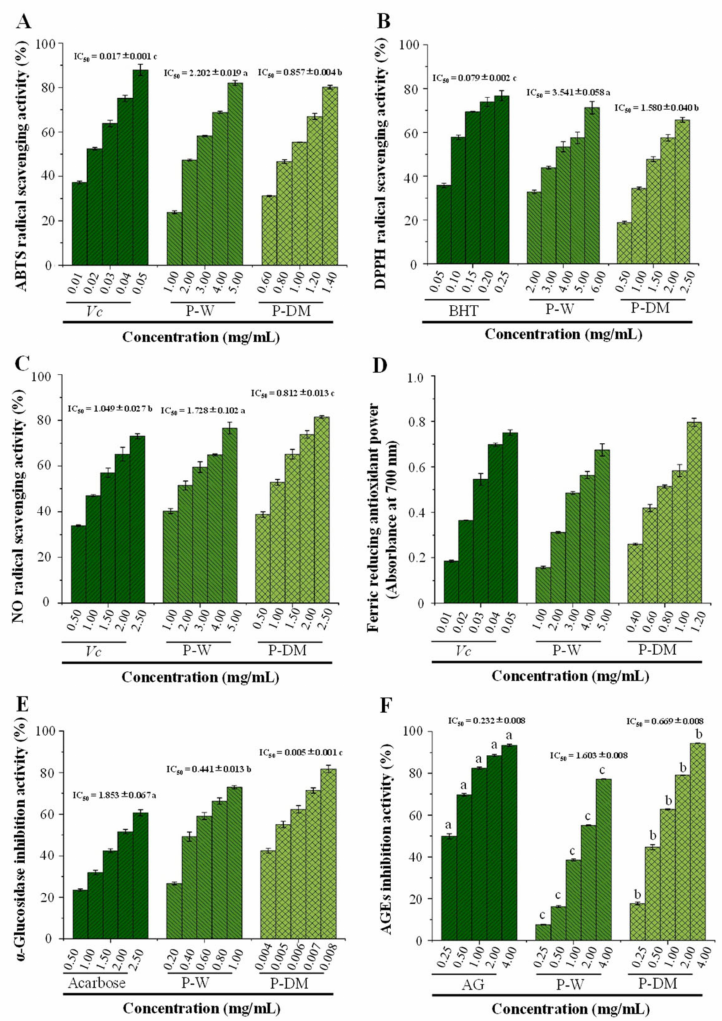
Figure 6. ABTS ( A ), DPPH ( B ) and NO ( C )radical scavenging activities, reducing power ( D ), in- hibitory activity against α -glucosidase ( E ), and antiglycation effect ( F ) of polysaccharides extracted from sweet tea leaves. P-DM and P-W indicate polysaccharides extracted from sweet tea leaves by microwave-assisted deep eutectic solvent extraction and hot water extraction, respectively; Significant differences ( p < 0.05) among the positive control, P-DM, and P-W are shown by data bearing different letters